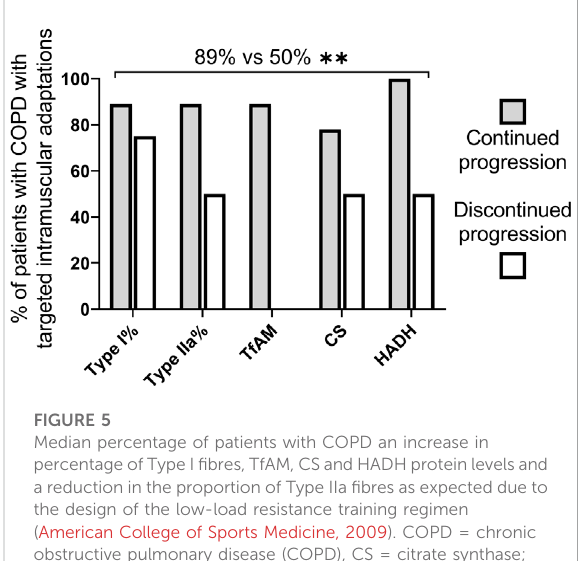
FIGURE 5 Median percentage of patients with COPD an increase in percentageof Type I fi bres, TfAM, CS and HADH protein levels and a reduction in the proportion of Type IIa fi bres as expected due to the design of the low-load resistance training regimen (American College of Sports Medicine, 2009). COPD = chronic obstructive pulmonary disease (COPD), CS = citrate synthase; HADH = hydroxyacyl-coenzyme A dehydrogenase; TfAM =